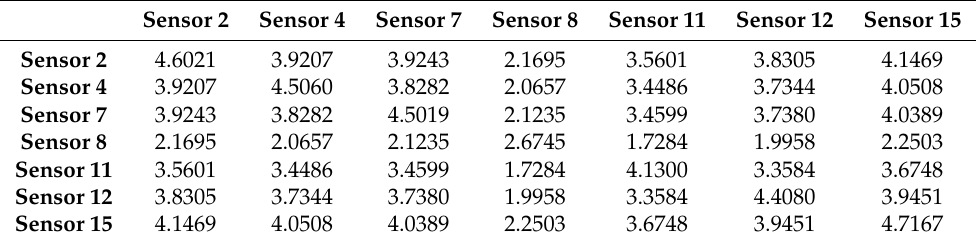
Table 7. Mutual information values among sensors selected by observing strategy for data set 2.